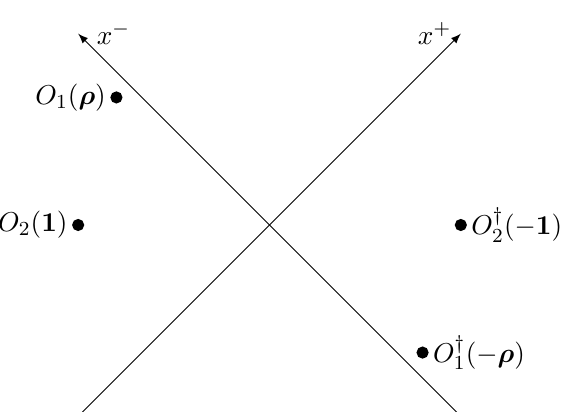
Figure 2 . Lorentzian four-point correlator (3.2) where all operators are restricted to a 2 d subspace.